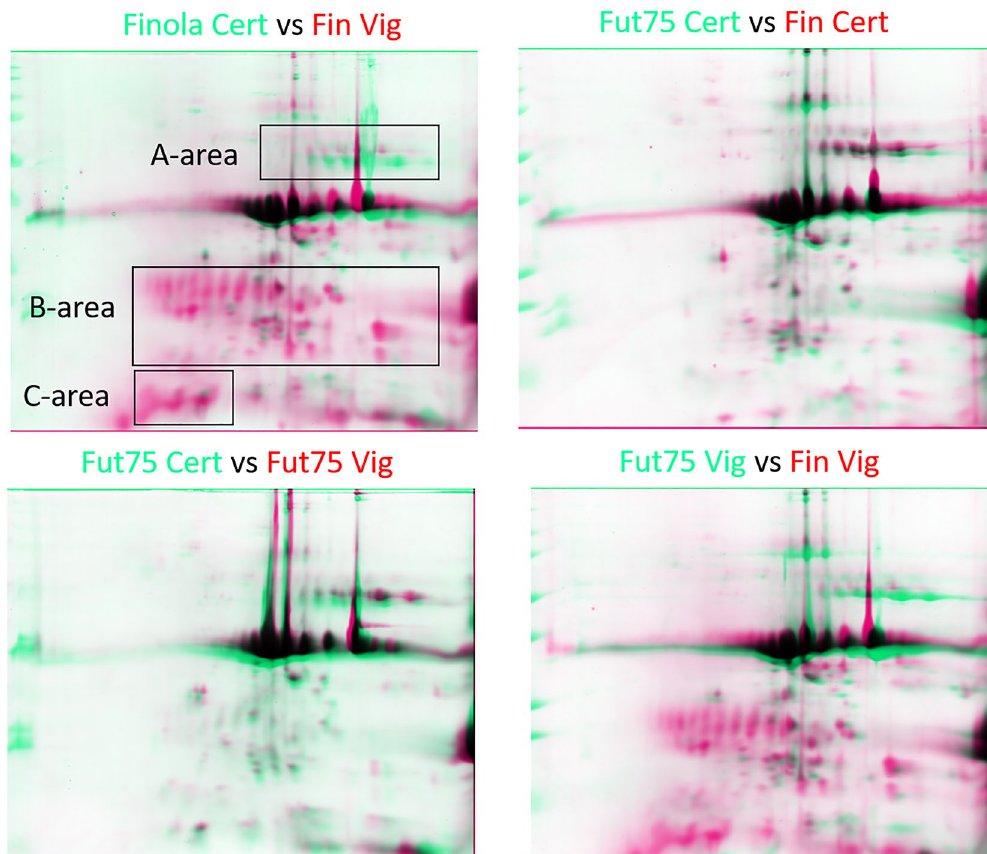
Figure 6. Overlapping images from 2D-gels of total protein extracts: certified and harvested seeds from the experimental field of Viganella, Finola and Futura 75 varieties. The three areas ( A , B , C ) define gel zones mainly affected by changes in protein distribution.